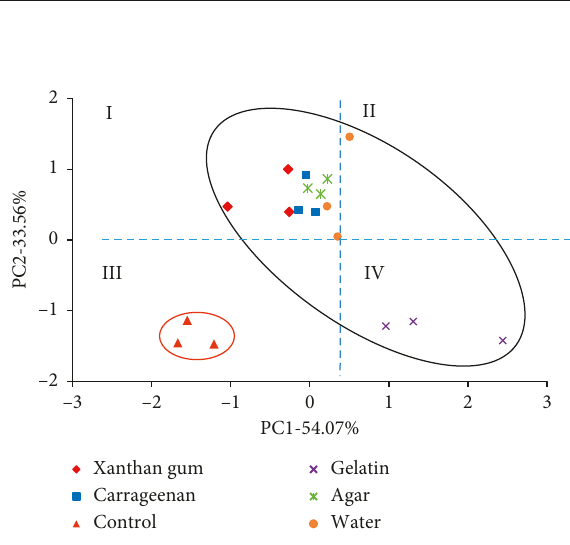
Figure 4: PCA scores for pork samples injected with different hydrocolloid